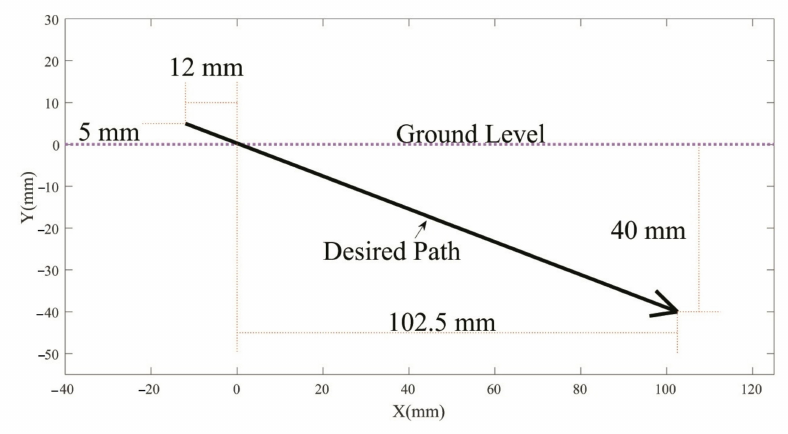
Figure 1. The desired path for a coupler point of the four-bar